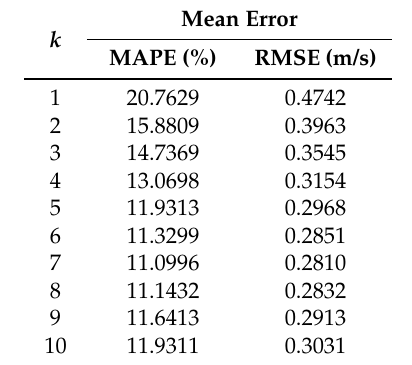
Table 2. Mean error of one-step-ahead forecasting using the new method with different k values.